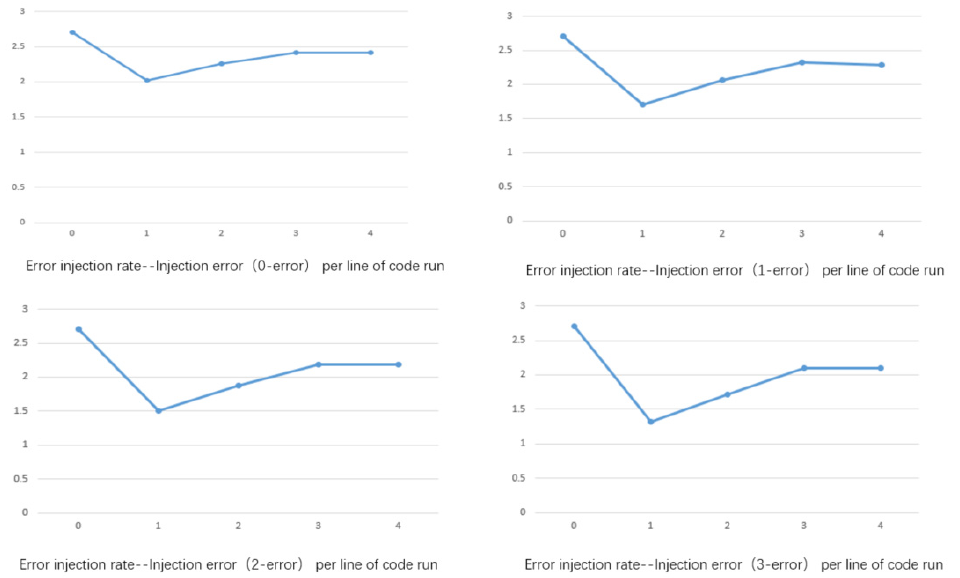
Figure 32. CoreMark running scores under different error injection frequencies. Table 1. Running results of CoreMark and Dhrystone under different error